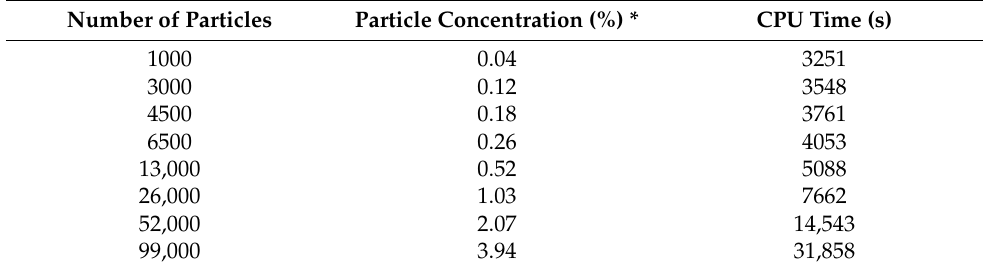
Table 3. CPU time (s) to carry out simulations. Number of Particles Particle Concentration (%)